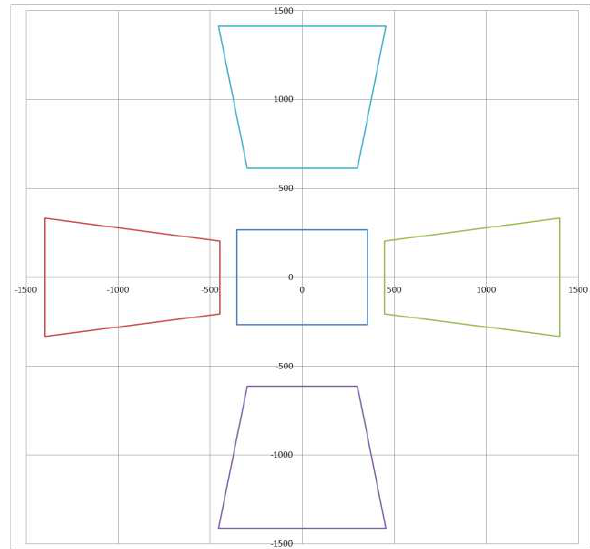
Figure 2: The calculated footprint of the OIS The mission was controlled by the flight management software AeroTopoL. All images are geo y, z, roll, pitch and heading, and additionally with the gyro stabilized mount AeroStab XL. Besides that the precise ex ternal orientation was achieved with a L1/L2 GNSS and a fiber- optical IMU which results in a few cm accurate position and attitude values at about 10